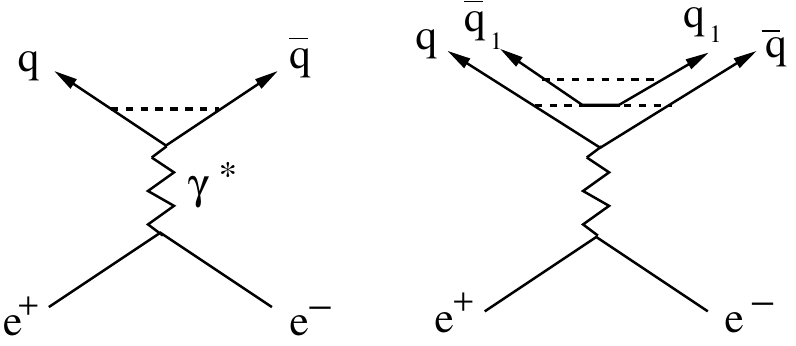
Figure 2. Quark formation in the e + e −